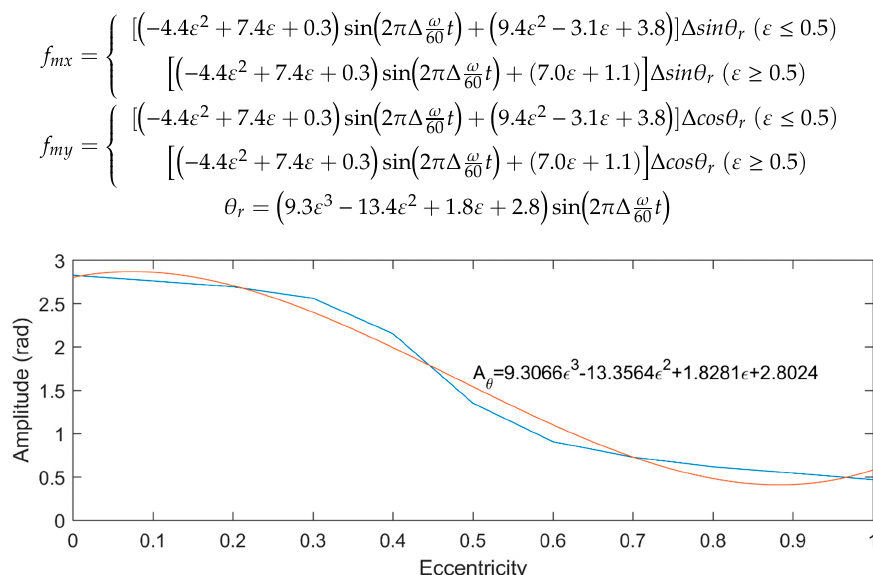
Figure 9. Amplitude fluctuation of θ r